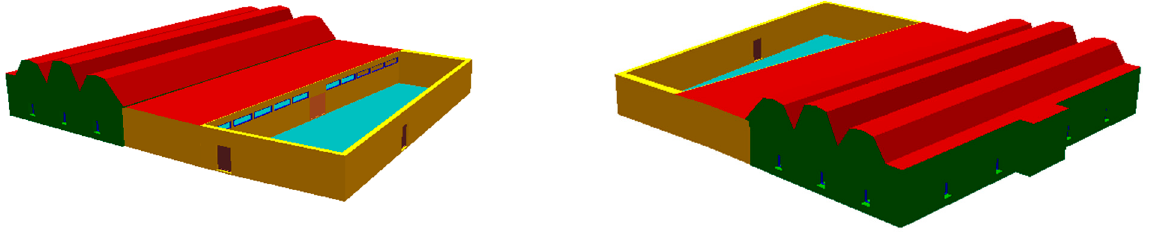
Figure 8. Three ‐ dimensional (3D) views of Al Wafi Mosque.